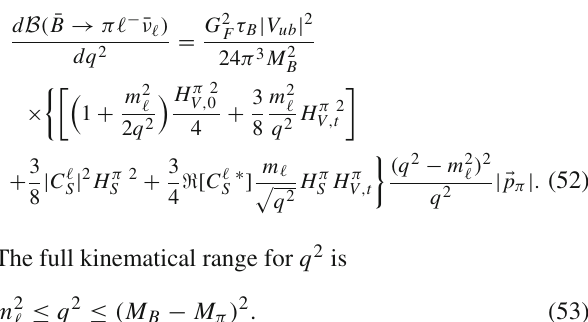
Fig. 6 Allowed regions in the C μ R τ μ and R (cid:3) e ,μ (cid:4); ρ [ q 2 ≤ 12 ] GeV 2